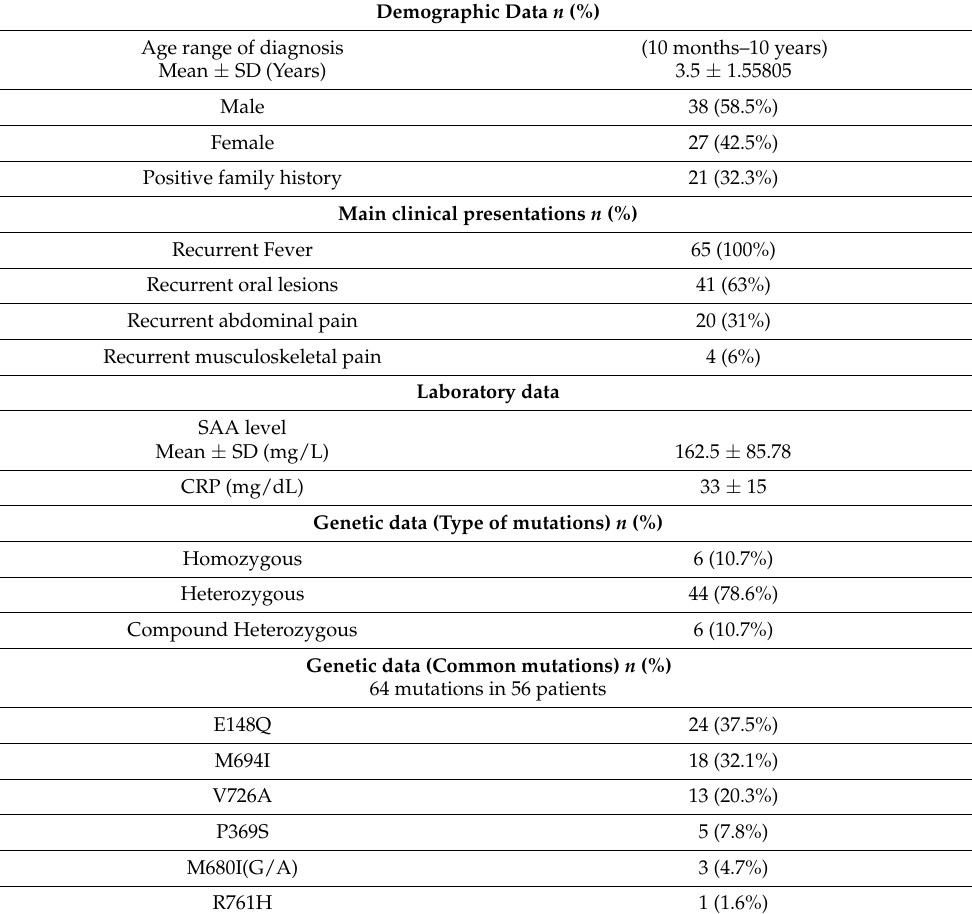
Table 2. Patient’s basic